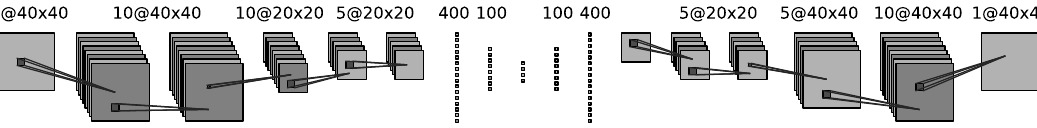
Figure 2: Architecture of the image-based autoencoder network. The 40 × 40 images are average-pooled to 20 × 20 images before entering the bottleneck. The dense units are first reduced from 400 to 100, the minimum size at the bottleneck is